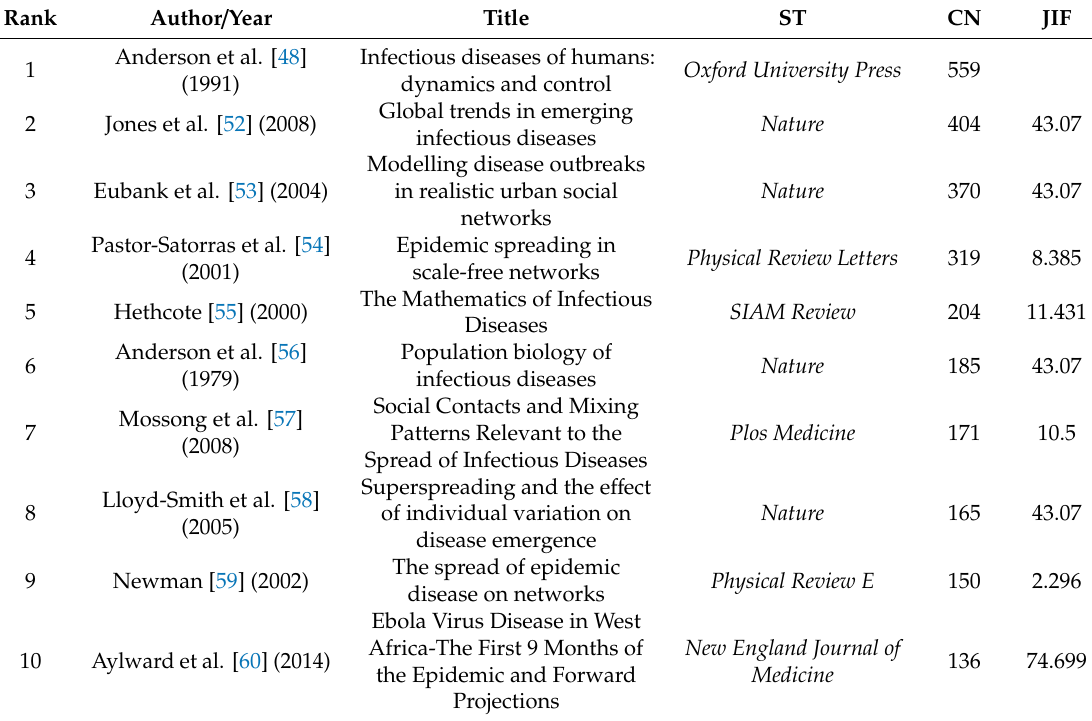
Table 5. The top 10 cited publications in the field of prediction of infectious diseases.